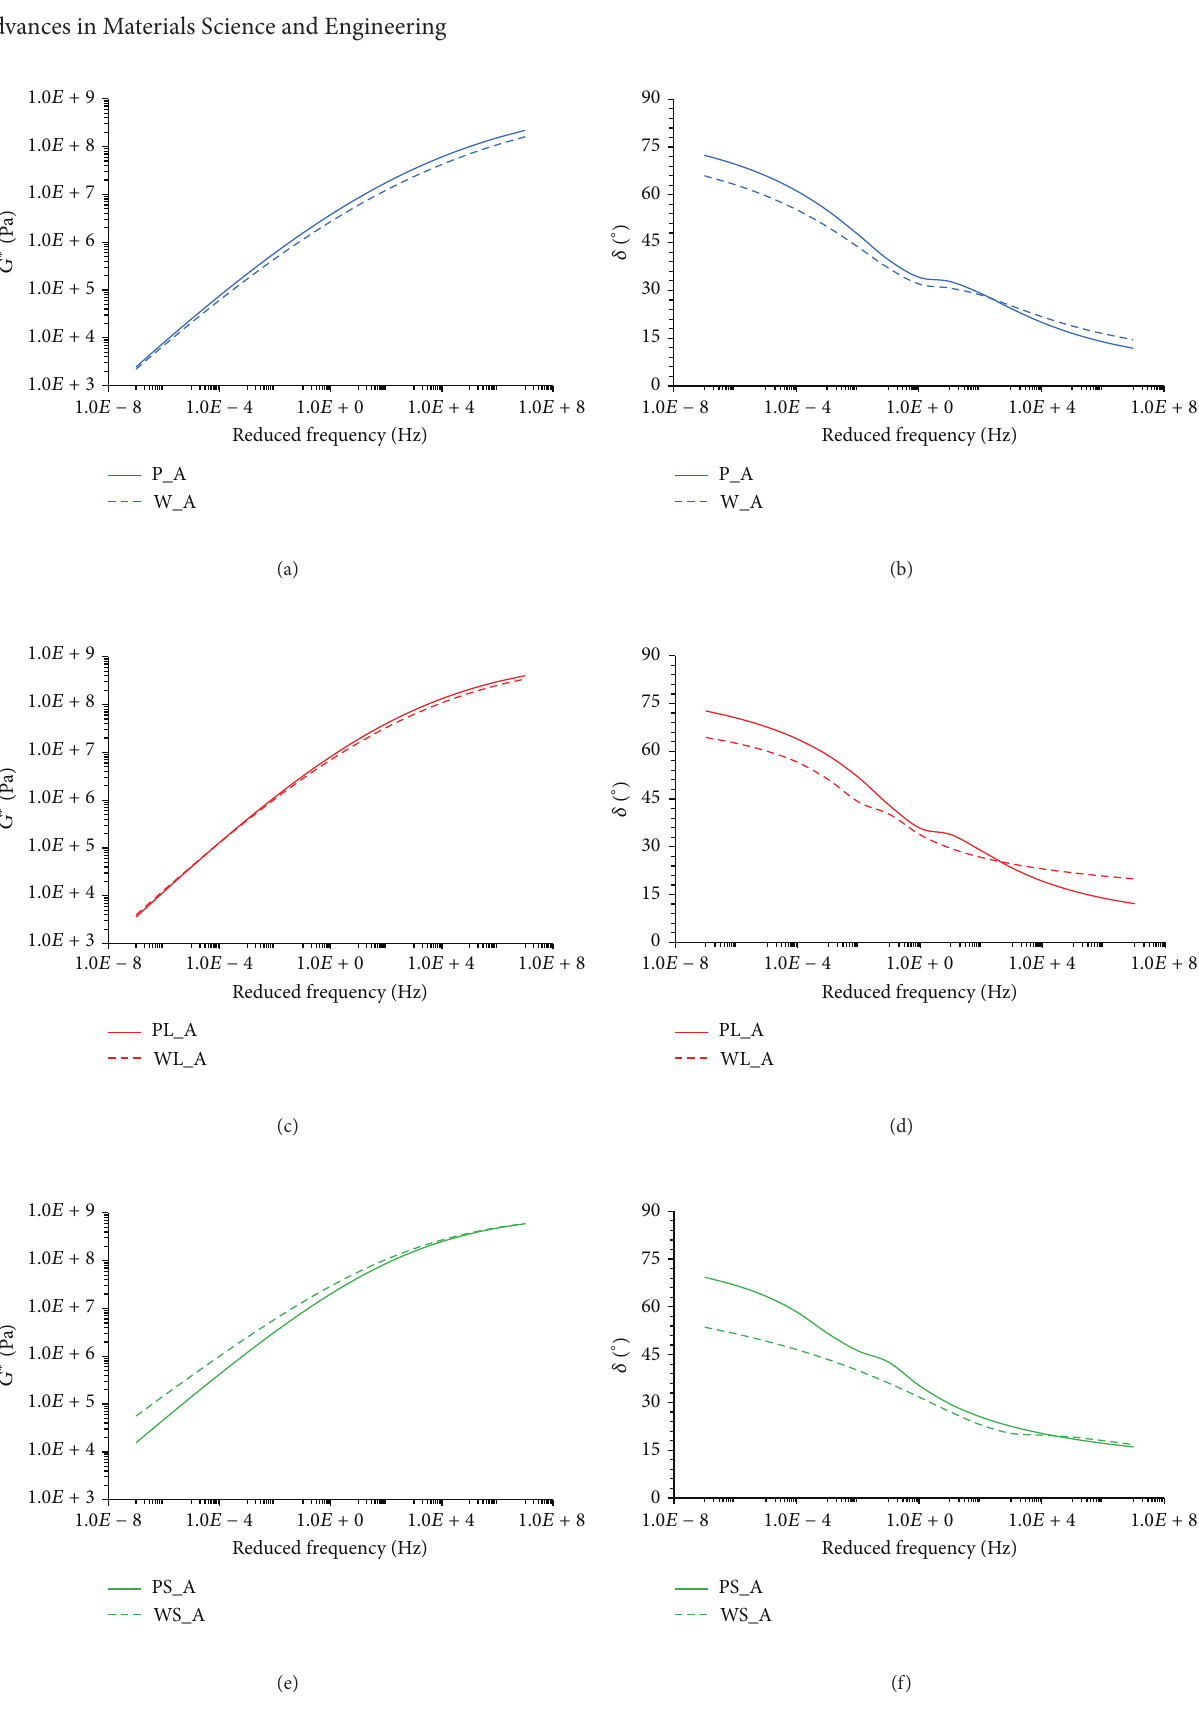
Figure 5: 𝐺 ∗ (left) and 𝛿 (right) master curves for binders (a, b), limestone mastics (c, d), and steel slag mastics (e,